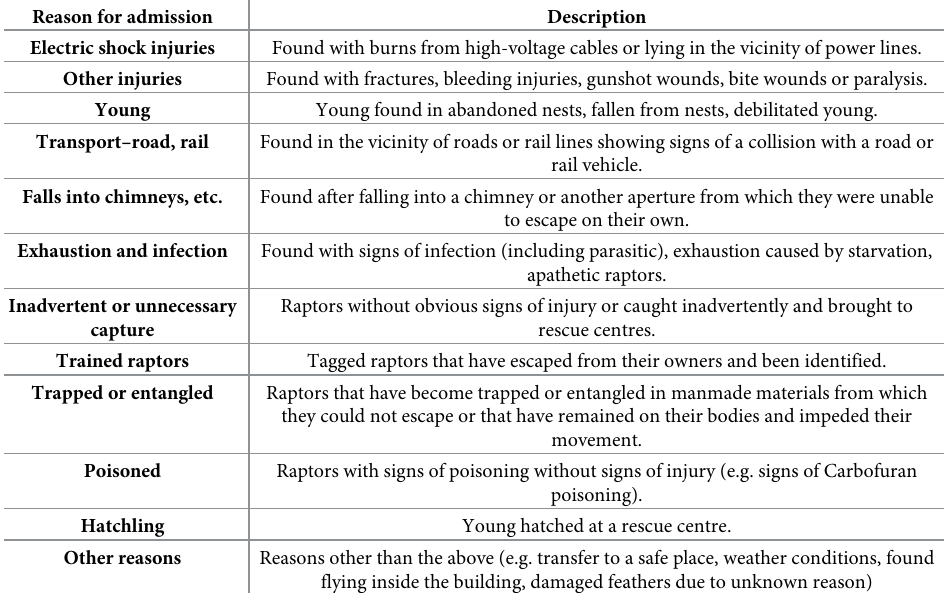
Table 1. Reasons for the admission of raptors to rescue centres in the Czech Republic used by the National Net- work of Rescue Centres.